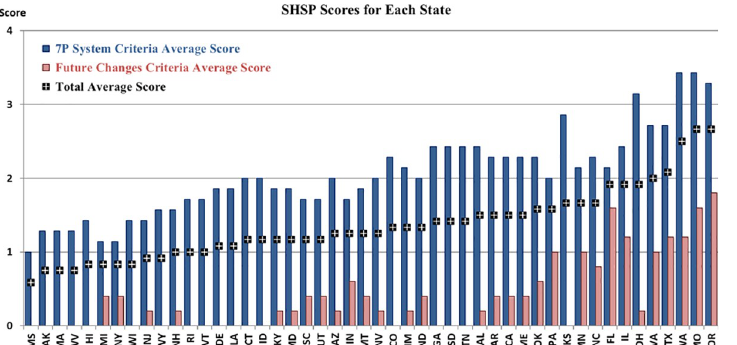
Fig 4. Individual SHSP assessment